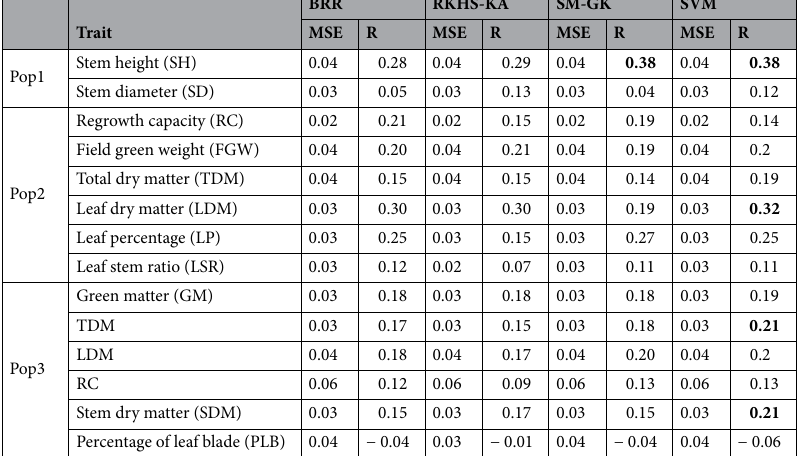
Table 2. Accuracies for Bayesian ridge regression (BRR), the reproducing kernel Hilbert space with kernel averaging (RKHS-KA) model, the single-environment, main genotypic effect model with a Gaussian kernel (SM-GK), and support vector machine (SVM)-based regression across the different traits separated according to the populations: (Pop1) cross between sugarcane commercial varieties, (Pop2) cross between a commercial variety and a genotype of Urochloa decumbens , and (Pop3) cross between a commercial variety and a genotype of Megathyrsus maximus . The accuracies are estimated through mean squared errors (MSE) and Pearson correlation coefficients (R). The values in bold represent the top 5 accuracies